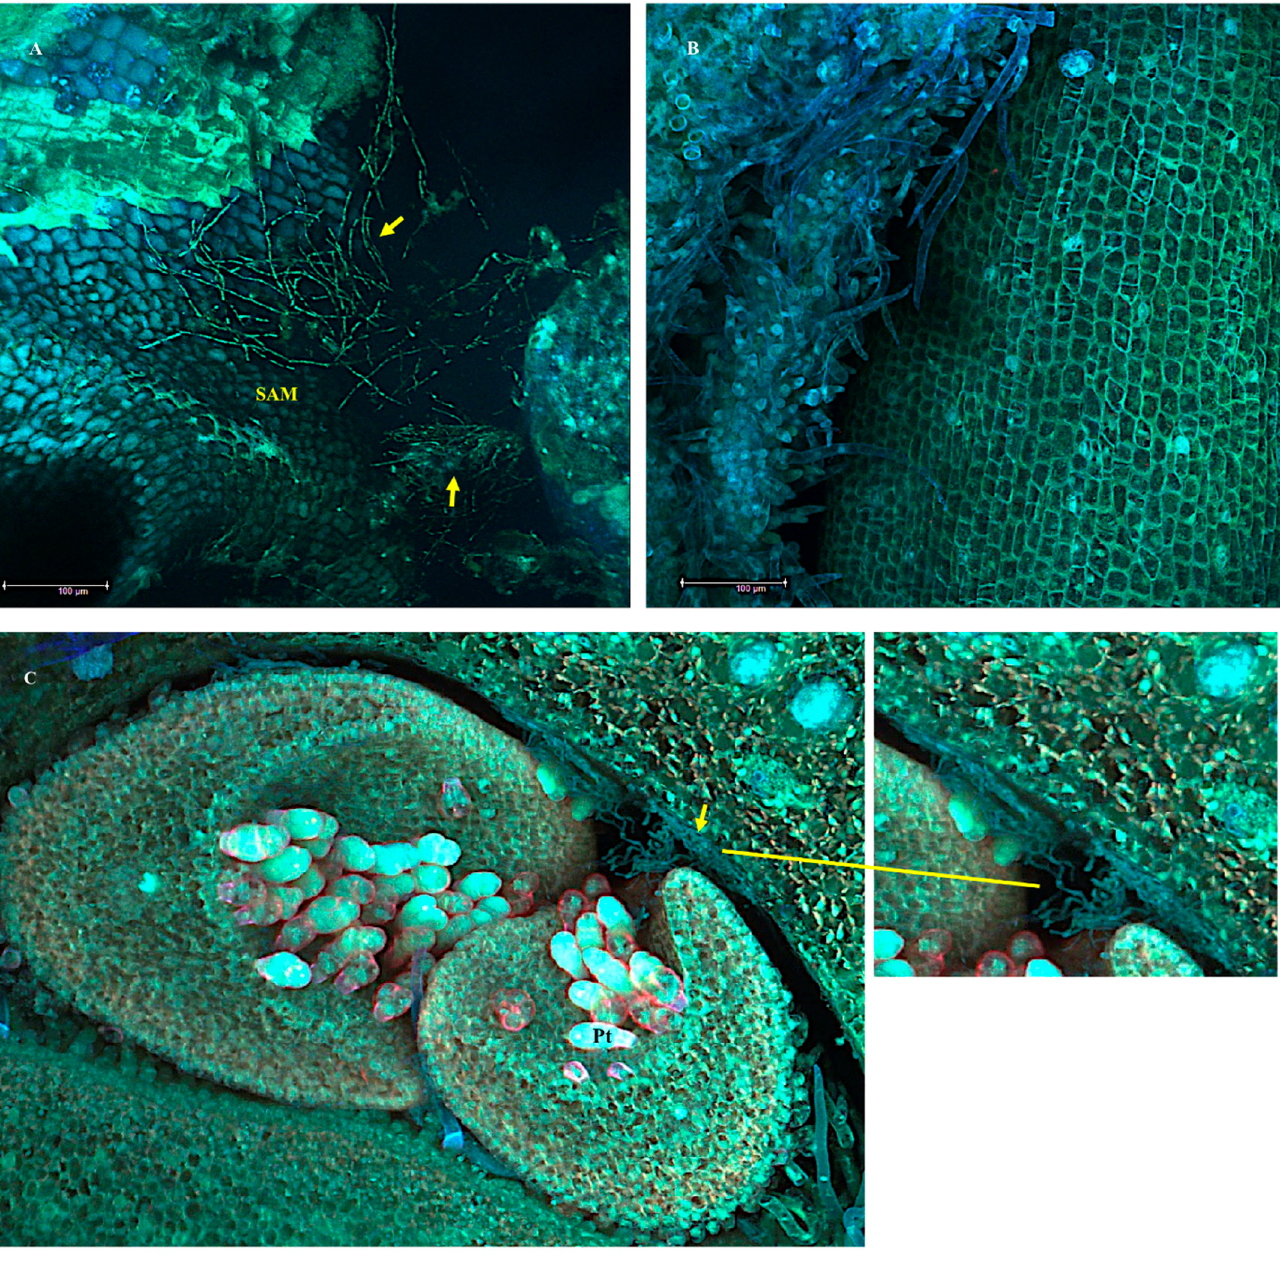
Figure 8. Fluorescent laser scanning confocal microscope images showing network of mycelia in the shoot apical meristem (SAM) of a 5-day-old I. carnea positive plant colonizing intercellular spaces indicated by arrows ( A ), and no evidence of mycelia in the SAM of a 5-day-old negative plant ( B ). Mycelia in the SAM of 5+ year-old positive plant indicated by arrows ( C ). Peltate glandular trichome (Pt). Scale bar—100 μ m.